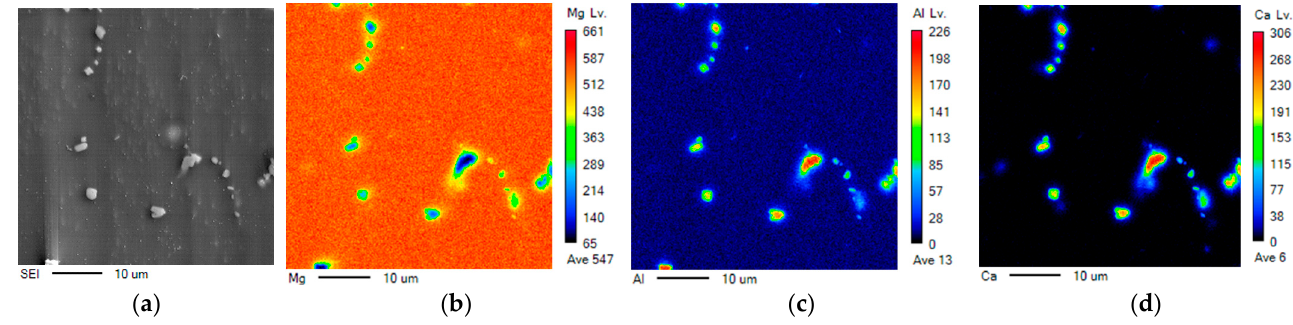
Figure 3. The result of EPMA in AZX611 as-received specimen shown in Figure 1d. Each figure shows the ( a ) SEI image and the distribution of ( b ) Mg, ( c ) Al and ( d ) Ca